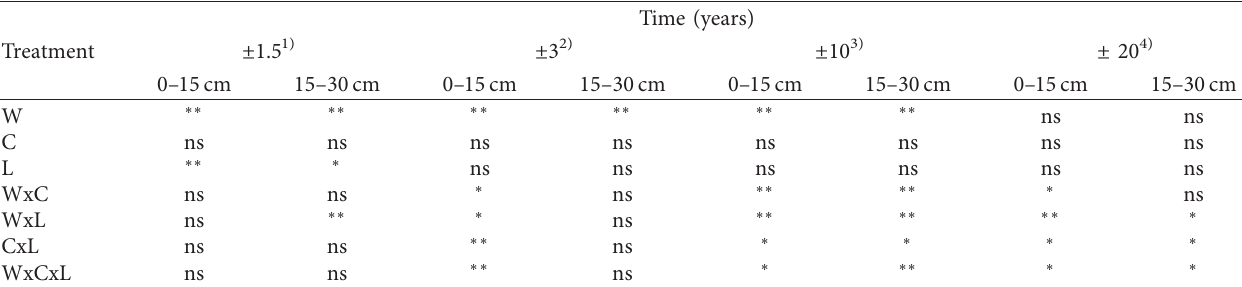
Table 4: The effect of the 20-year-old amendment of industrial waste, lime, and cassava-leaf compost on the soil Zn concentration.